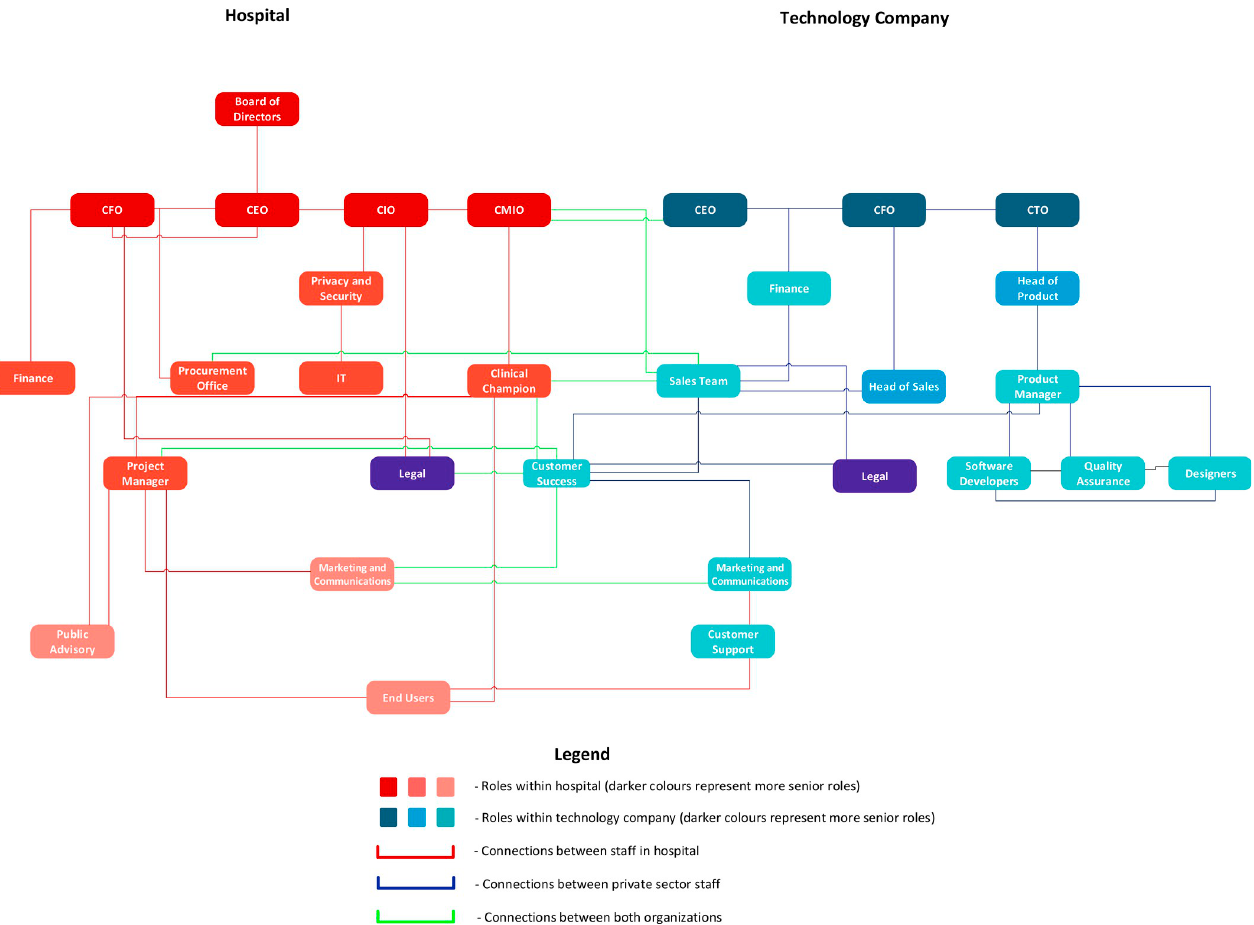
Fig 2. Generalized partnership logic diagram between technology companies and